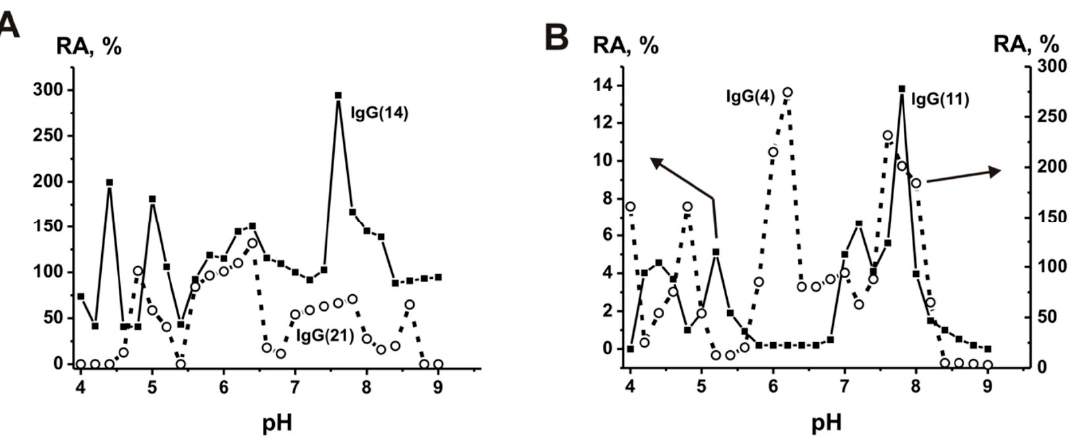
Figure 2. Dependences of the relative catalase activity of four schizophrenic patients’ IgGs on pH of the reaction mixture ( A , B ). All relative activities of IgG(14) at pH 7.0 were taken for 100 percent. The errors in the initial rate determination from three experiments in each case did not exceed 7–10% [161].